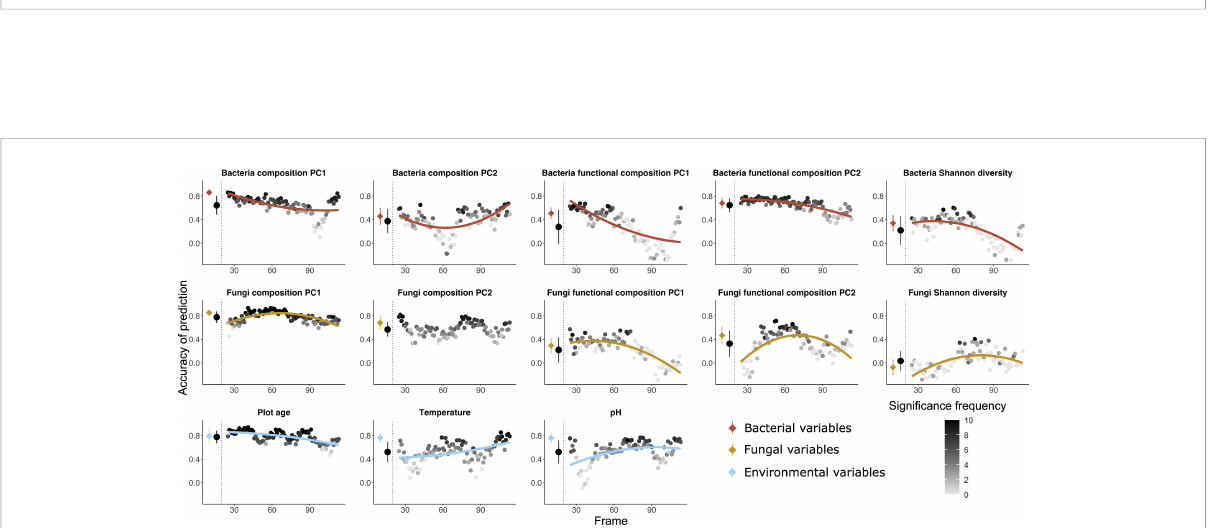
FIGURE 3 Random forest predictions using the community table of plant communities as explanatory variable to predict fi ve variables of bacteria (red), fi ve variables of fungi (orange) as well as three variables of environmental factors (blue) as dependent variables. The prediction was done both using all the 135 plots and using a moving frame approach. For the moving frame approach, every 45 plots were grouped into one frame and the median plot was used as identi fi er of the frame. Thus, the fi rst frame included plots 1 to 45, the second 2 to 46, and so forth. The x axis represents the median plot of every frame whose identi fi ers ranged from plot 23 to plot 113 (i.e. from young successional plots to old plots). The colored circles at the left of each plot denote the mean ± standard deviation of the accuracy of prediction (Pearson ’ s r) using the full dataset (results of 10-fold cross validation), and the black circles denote the mean ± standard deviation of the accuracy of prediction for all the frames. Each grey to black circle on the right of each plot represents the mean accuracy of prediction of each frame and the color gradient is showing how many correlations of the 10-fold cross-validation were signi fi cant with lighter colors indicating less frequent signi fi cant predictions. A quadratic or linear regression (the model with higher adjusted r 2 value) is fi t for the gradient if it is signi fi cant, showing a change of the accuracy of prediction along the successional gradient.